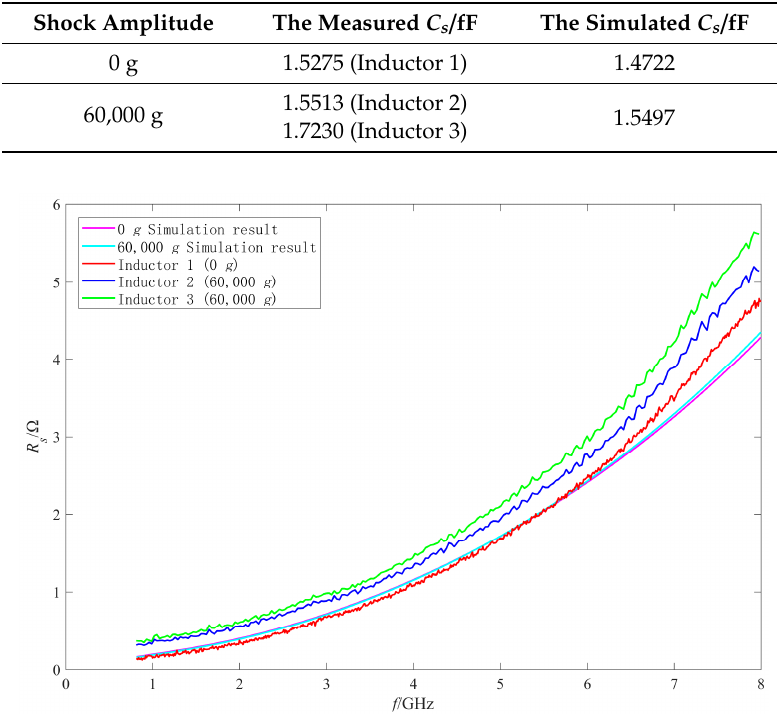
Figure 19. The measured and simulated 𝑅 (cid:3046) of the intact inductors before and after shock test.